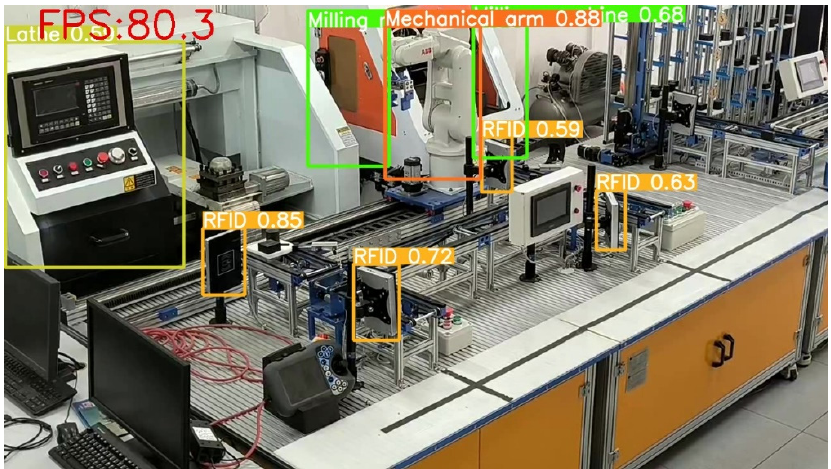
Figure 17. FPS test results of the improved method.